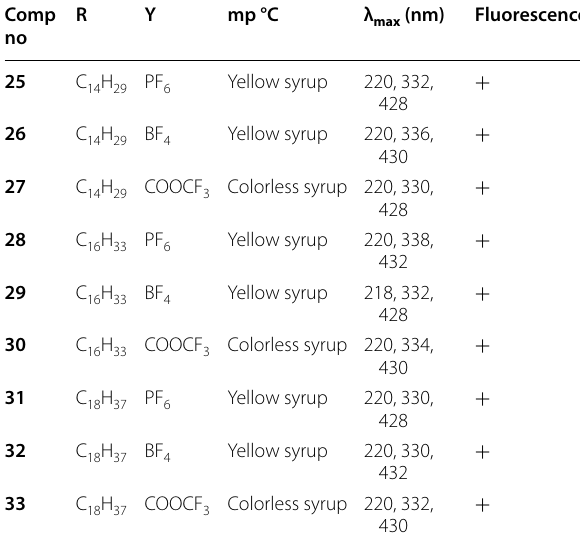
Table 4 IC values (µM) on 4 different cancer cell lines 50